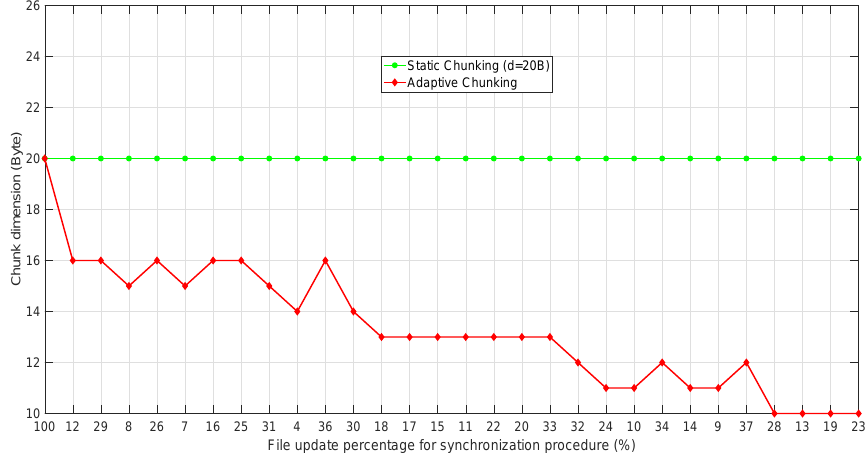
Figure 8. Chunk dimension adaptation as the synchronization events